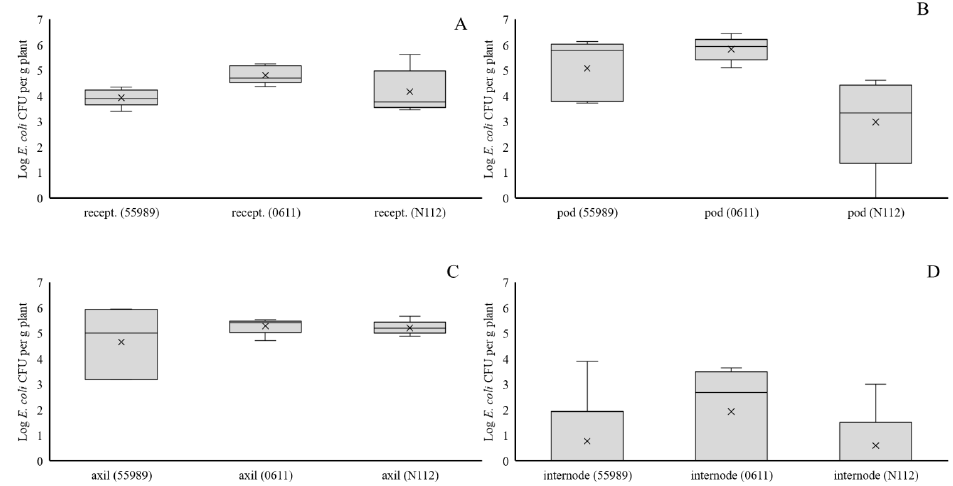
Figure 4. Colonization of flower receptacles at 50 DAS ( A ), pea pods at 80 DAS ( B ), leaf axils at 50 DAS ( C ) and first internode above the leaf axil at 50 DAS ( D ), upon injection of three E. coli strains (55989, 0611, or N112) into, respectively, flower receptacles ( A , B ) or leaf axils ( C , D ) at 45 DAS.